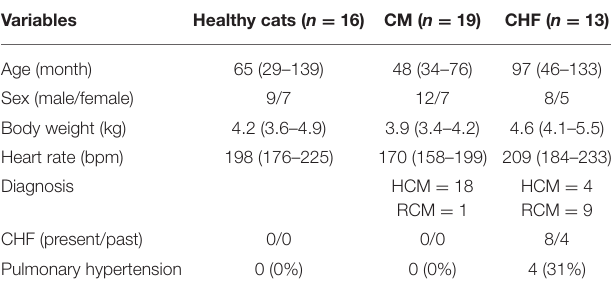
TABLE 1 | Clinical characteristics in cats with cardiomyopathy and healthy controls. Variables